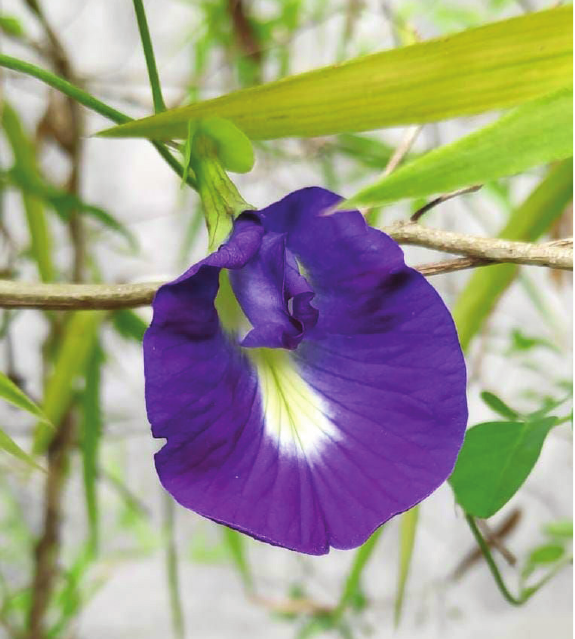
Figure 1. Photographic image of Medan Butterfly